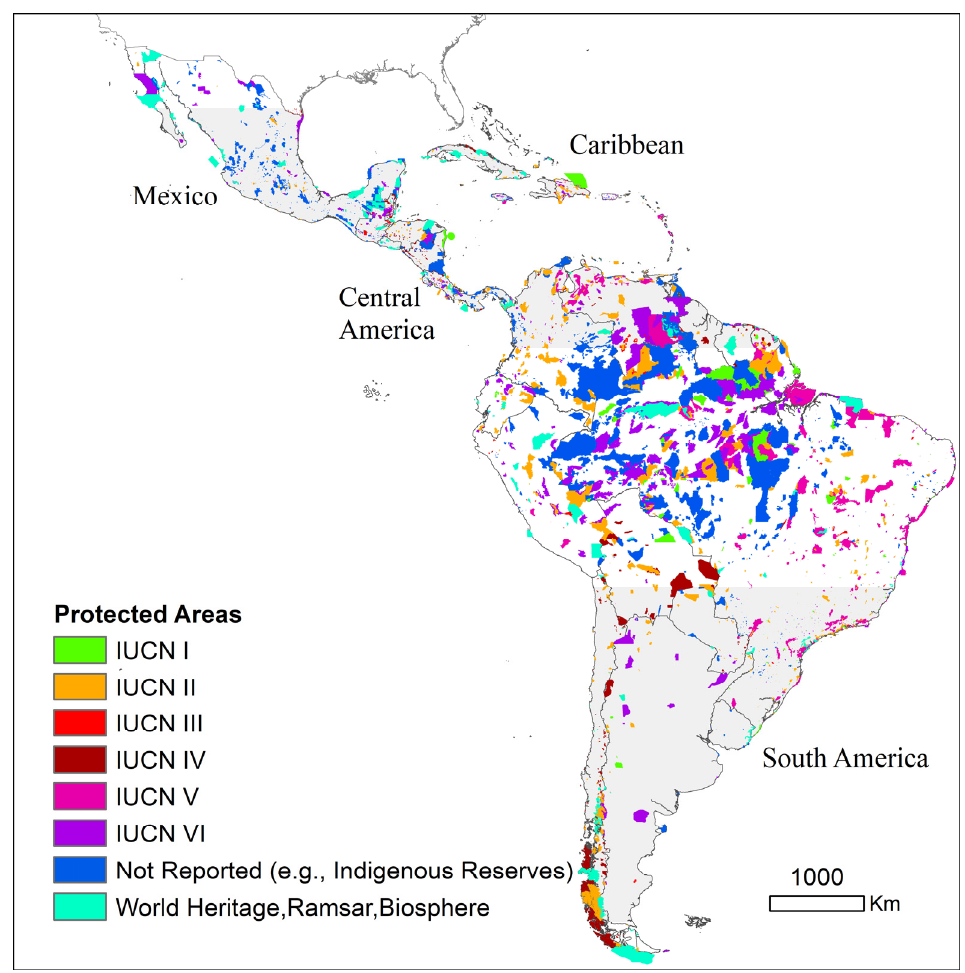
Figure 2. TPAs in Latin America and the Caribbean [34], designated as of September 2012.